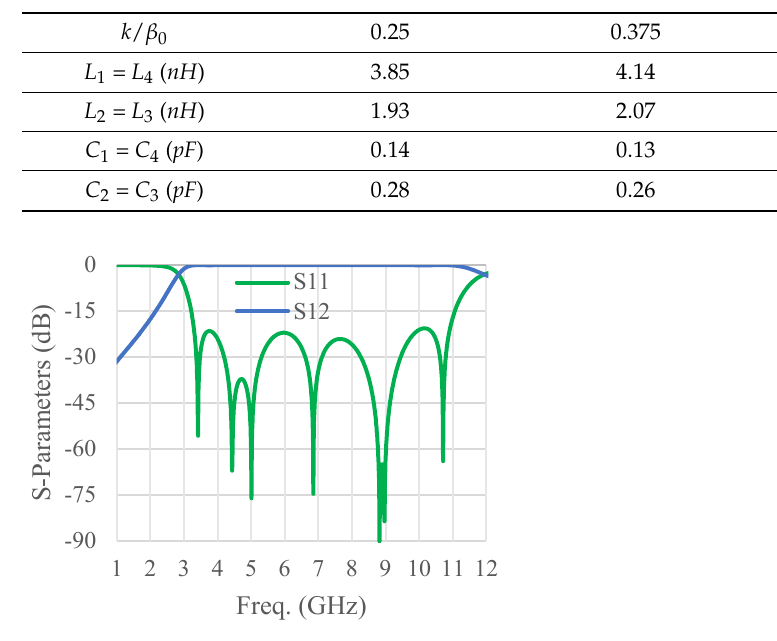
Figure 8. Simulated S − parameters results of the lumped element filter represented in Figure 7.